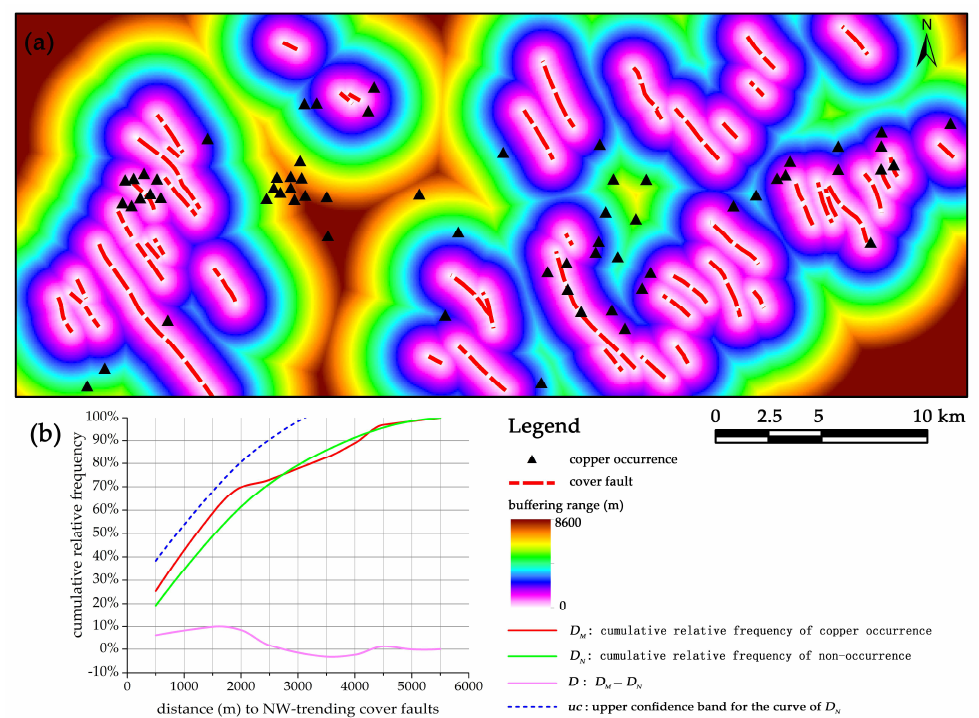
Figure 10. ( a ) Buffer analysis and ( b ) graph of cumulative relative frequency concerning distance to NE-trending faults.